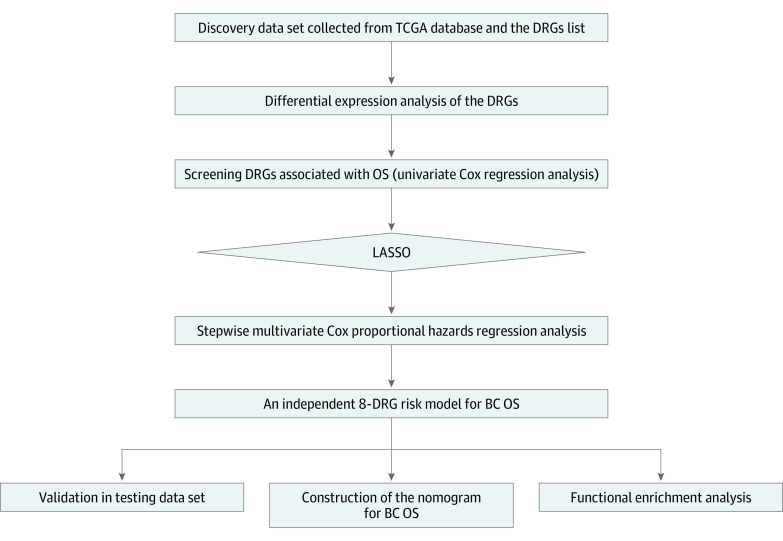
Flowchart of the Research DesignBC indicates breast cancer; DRGs, DNA repair–related genes; LASSO, least absolute shrinkage and selection operator; OS, overall survival; and TCGA, The Cancer Genome Atlas.